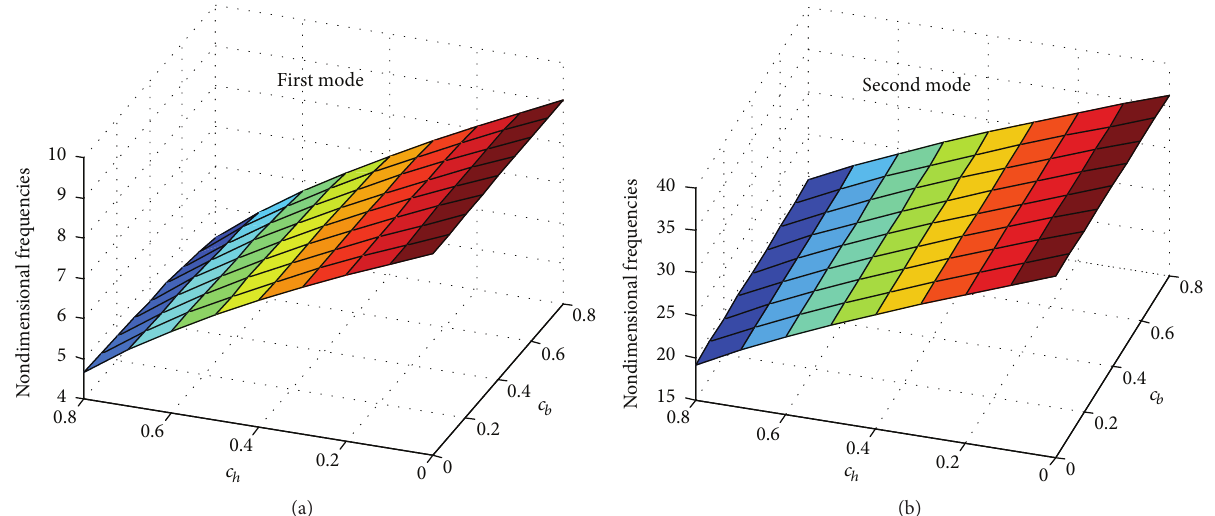
Figure 9: The variation of the first two nondimensional natural frequencies of axially FG beams with respect to taper ratios; boundary condition: P-P.